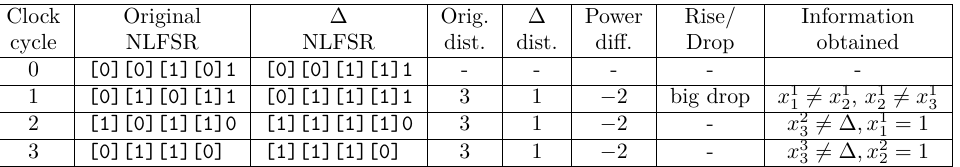
Table 5: Toy NLFSR example: Power consumption difference and bit relations obtained. Second and third columns are the register state of the original and with some difference, “Orig. dist.” and “∆ dist.” indicates the Hamming distance between the previous and current state, “Power diff.” indicates the numerical power consumption differences, “Rise/Drop” is the observation of the power consumption difference at the rising edge of the clock, and last column is the information